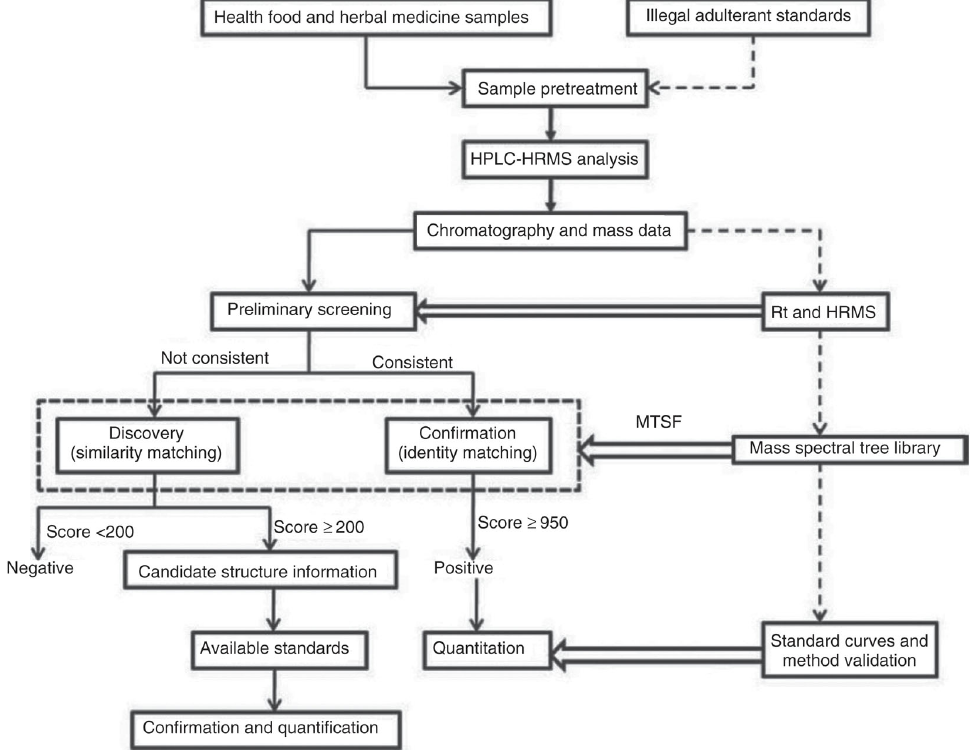
Figure 3: A workflow strategy for the detection, confirmation, and quantification of illegal adulterants by HPLC-HRMS and MTSF. Reprinted from Wang et al. (2015) with permission from John Wiley and